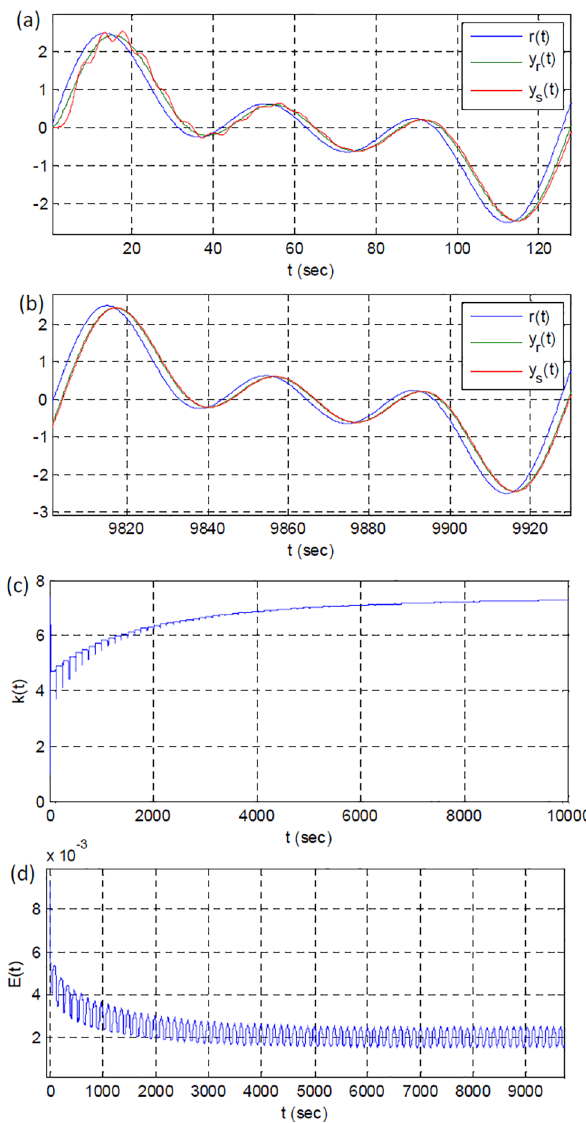
Fig 10. System outputs for continuous multi-sinusoidal reference input (a) at the beginningand (b) at the end of simulation, (c) adaptation gain, (d) short-time averagesquare error.